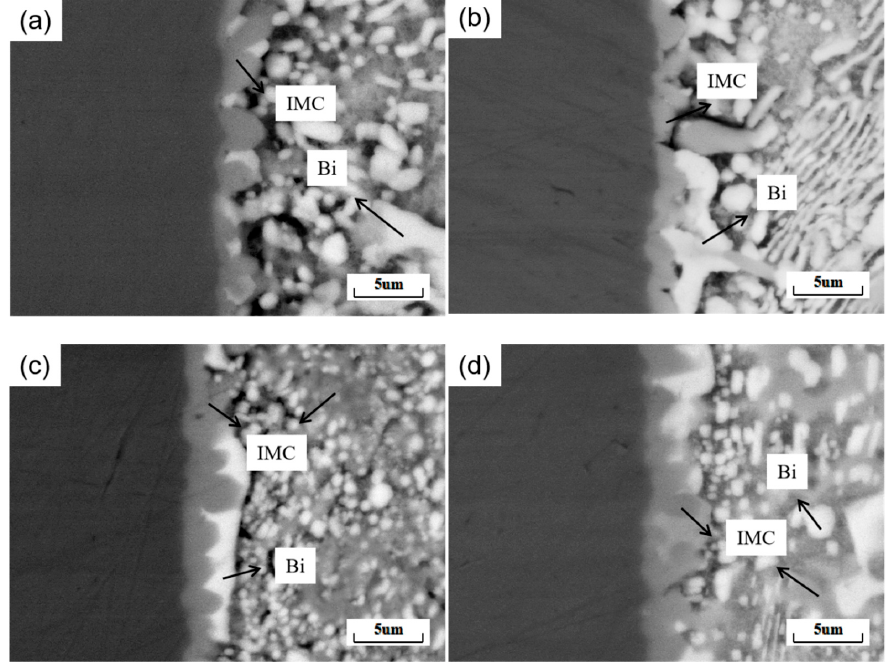
Figure 10. Secondary electron morphology of SnBiAg–xIn/Cu (x = 0, 0.5, 1.0, 1.5) solder joint cross-sections: ( a ) SnBiAg/Cu; ( b ) SnBiAg0.5In/Cu; ( c ) SnBiAg1.0In/Cu; ( d ) SnBiAg1.5In/Cu.